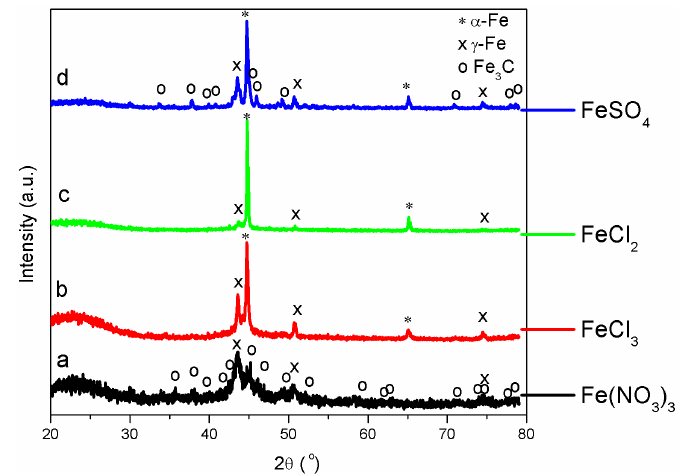
Figure 3. XRD patterns of Fe-lignin samples prepared using iron nitrate ( a ), iron(III) chloride ( b ), iron(II) chloride ( c ) and iron(II) sulfate ( d ) compounds.